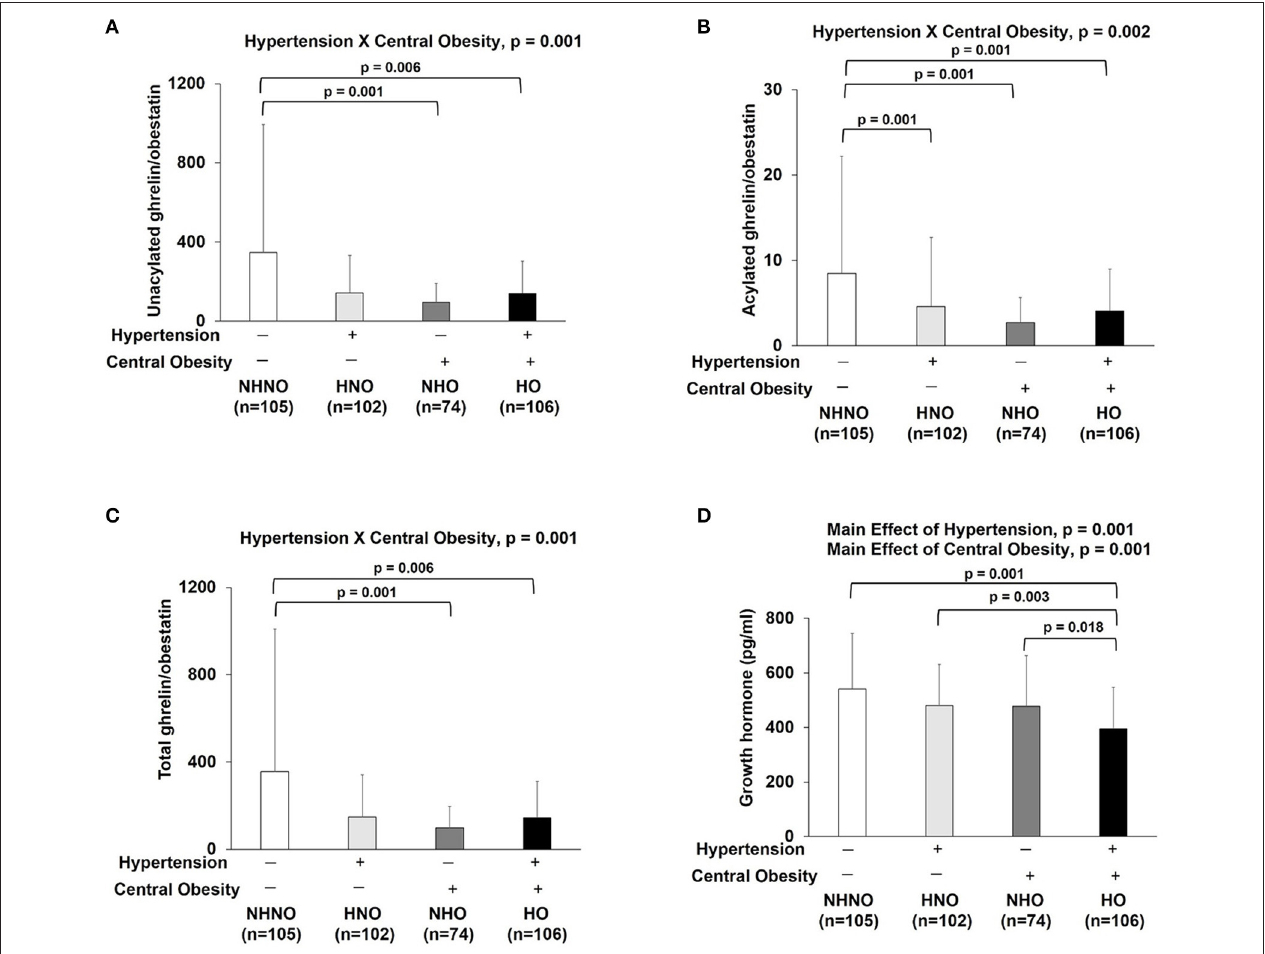
FIGURE 5 | Ratios of ghrelin gene products (unacylated ghrelin/obestatin, acylated ghrelin/obestatin and total ghrelin/obestatin) and growth hormone. There was significant interaction of hypertension with central obesity on unacylated ghrelin/obestatin, acylated ghrelin/obestatin and total ghrelin/obestatin ratios (A–C) . The ratios of unacylated ghrelin/obestatin and total ghrelin/obestatin were decreased in subjects with only central obesity and subjects with both hypertension and central obesity (A,C) . The ratio of acylated ghrelin/obestatin was decreased in subjects with hypertension, central obesity and both hypertension and central obesity (B) . There were significant main effects of hypertension and central obesity on growth hormone (D) . Growth hormone was decreased in subjects with hypertension and central obesity (D) . The main effects of hypertension and central obesity and the interaction of hypertension with central obesity were analyzed with generalized estimating equations. Significance level was set at p <